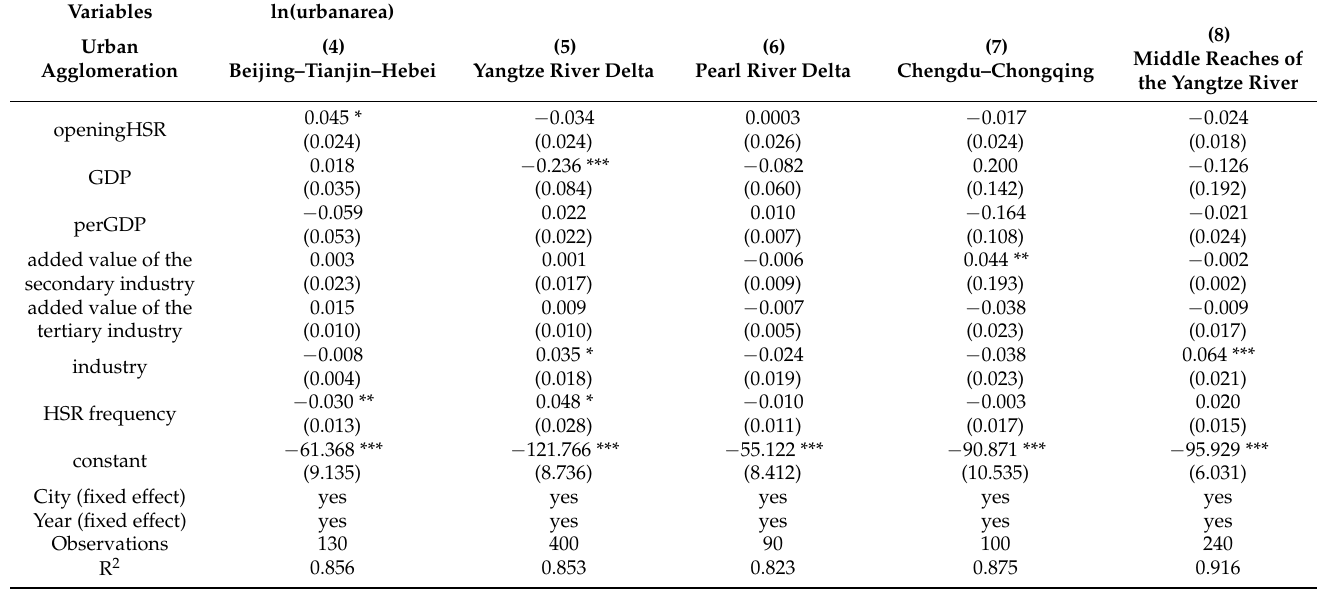
Table 3. The impact of HSR on urban expansion in five urban agglomerations in China.